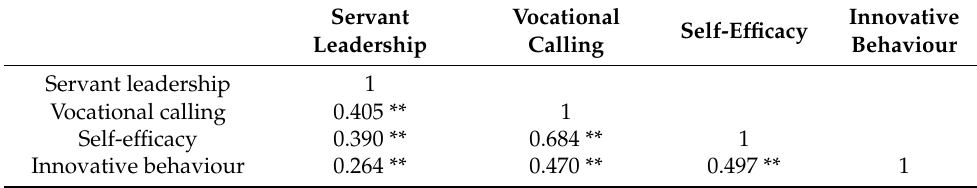
Table 2. Correlation